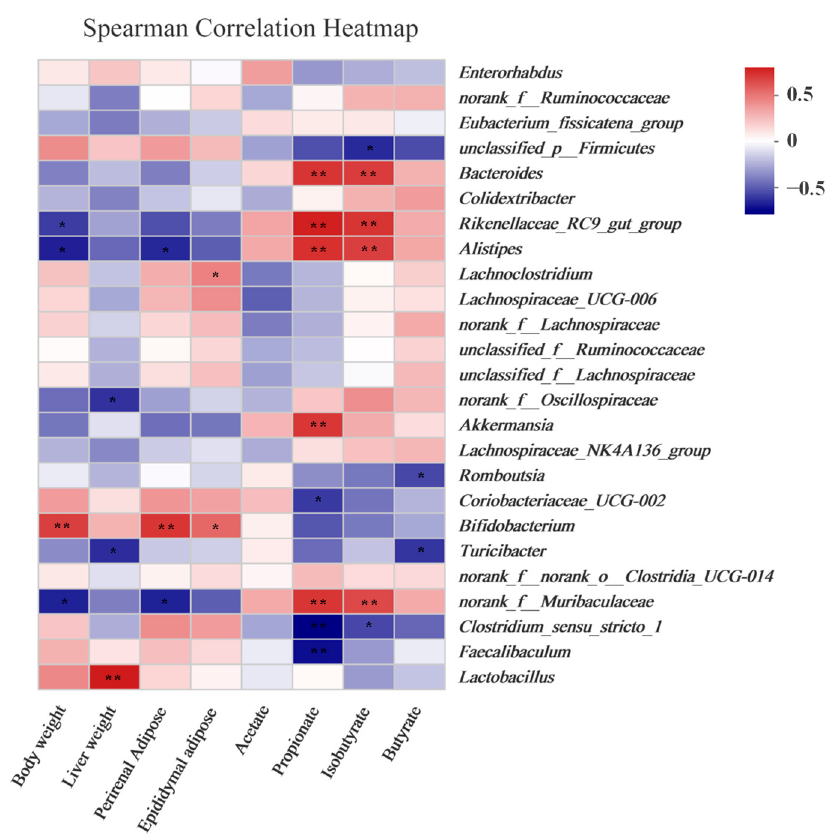
Figure 6. Correlation analysis. The heatmap shows Spearman correlations among the obesity-re- lated parameters and gut microbiota. Spearman correlations among the obesity-related parameters and gut microbiota. Significant correlations are displayed as * p < 0.05, ** p < 0.01.